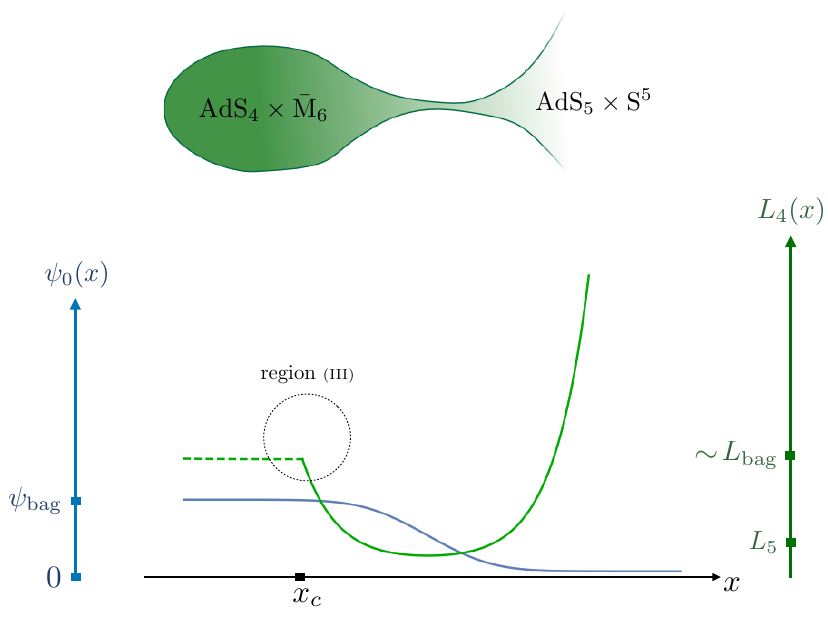
Figure 2 . Schematic drawing of the AdS 4 radius L 4 (green curve) and of the graviton wavefunction 0 (blue curve) as functions of the coordinate x of the Janus throat. The radius reaches a minimum value of L 5 inside the throat, and grows as L 5 cosh x on either side where the geometry asymptotes to AdS 5 = Z 2 (cid:2) S 5 . The left half of the throat is cut-o(cid:11) by the ‘bag’ at a characteristic radius (cid:24) L bag (cid:29) L 5 . The graviton wavefunction approaches a constant in this region, and vanishes exponentially at in(cid:12)nity. Since the matching region (III) contributes neither to the norm nor to the mass, it can be shrunk for our purposes to a